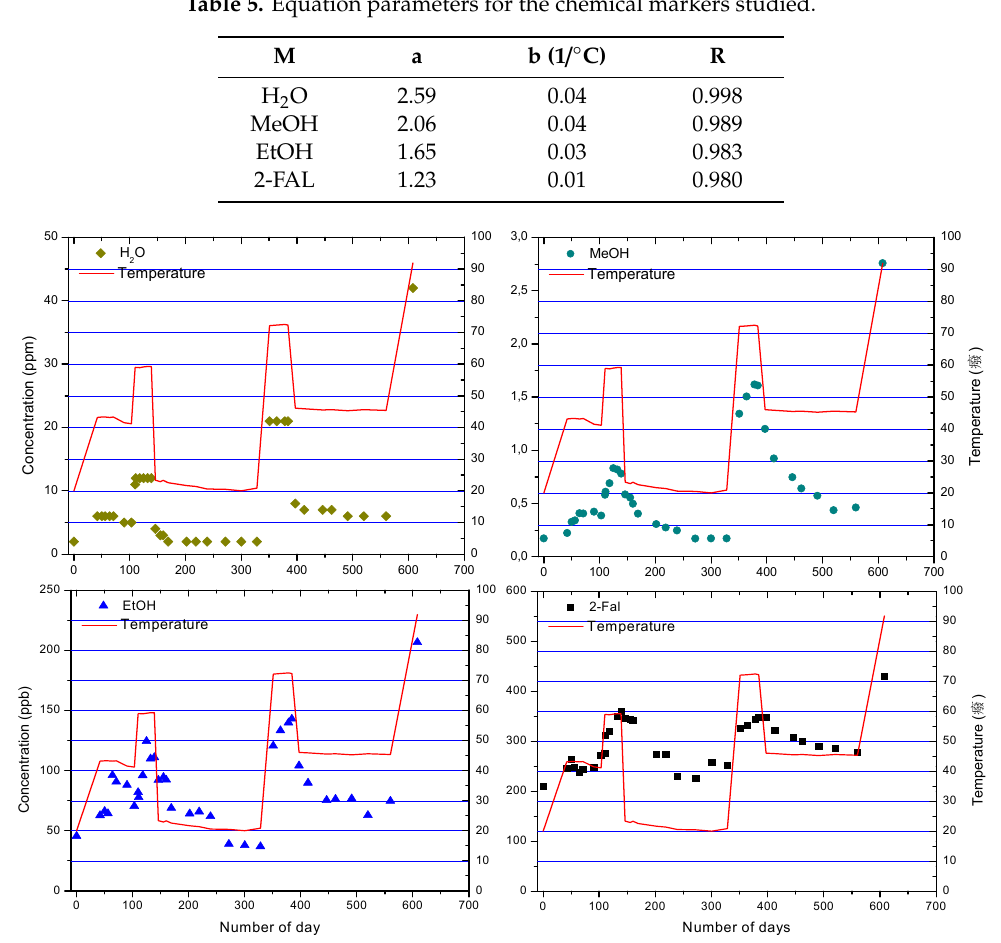
Table 5. Equation parameters for the chemical markers studied.